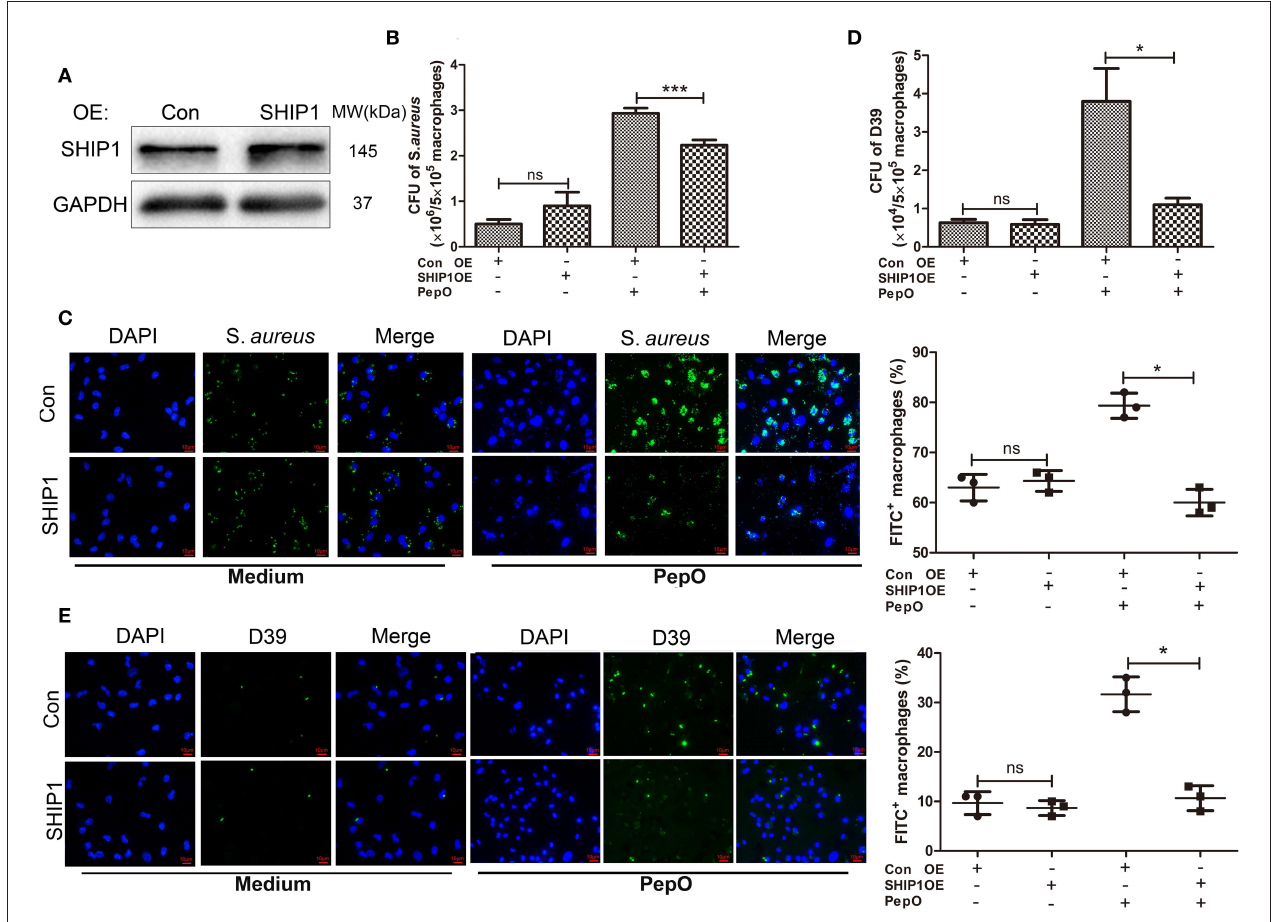
FIGURE 1 | The down regulation of SHIP1 mediates the enhanced phagocytosis of S. aureus and S. pneumoniae by PepO-stimulated macrophages. (A) Immunoblot showed the effective over-expression of SHIP1 in PEMs. (B,D) PEMs were transfected with pHBLV-CMV-SHIP1 plasmid or pHBLV-CMV-MCS control plasmid for 24h followed by PepO stimulation for another 24h and infection of S. aureus (B) or D39 (D) for 30min. The number of phagocytosed bacteria was determined. Data are shown as averaged ( ± SD) bacterial number of three independent repeated experiments. (C,E) PEMs were treated as described in (B) and infected with FITC-labeled S. aureus (C) or FITC-labeled D39 (E) for 30min. Representative pictures (original magnification, × 40) from one of the three experiments are shown. The quantification is shown as the averaged ( ± SD) percent of FITC + macrophages from three independent repeated experiments. Scale bar, 10 µ m. Statistical analysis was performed by two-way ANOVA test. *** p < 0.001, * p < 0.05, ns, not significant; OE, over-expression; Con,